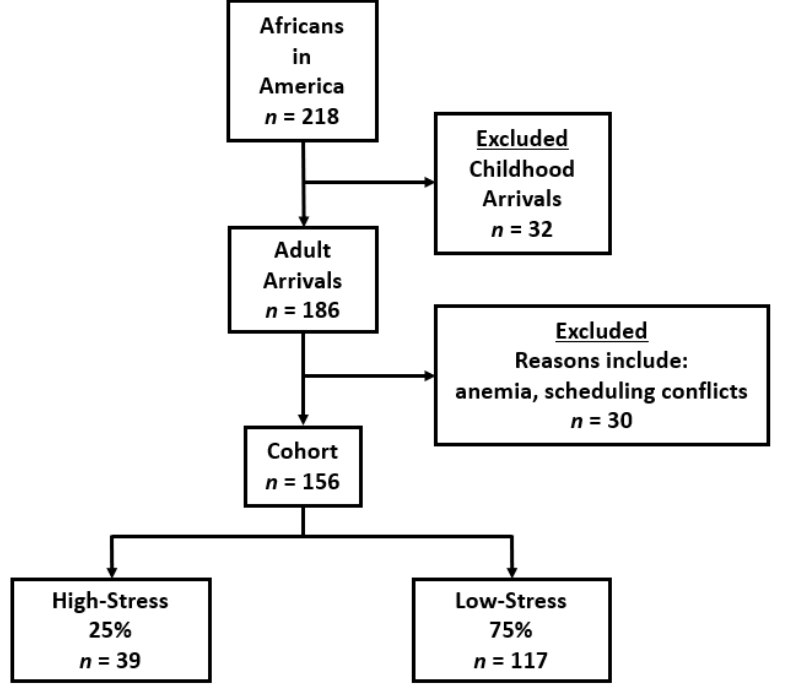
Figure 1. Flow Chart for Enrollment.